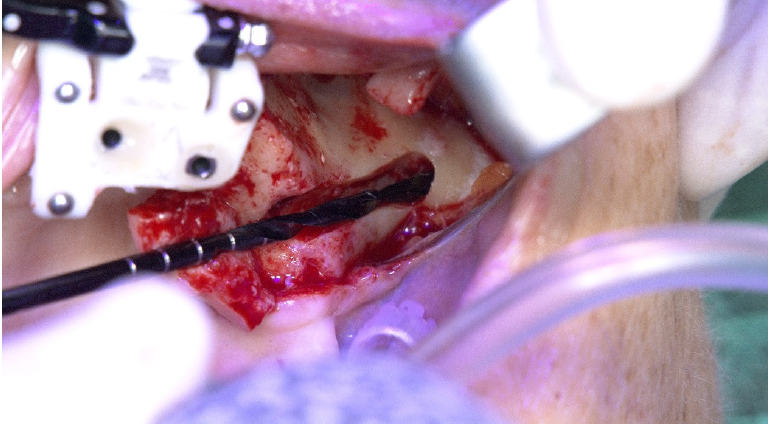
Figure 24. Perioperative photograph illustrating the use of the 2.9 mm twist drill for zygoma implant preparation.